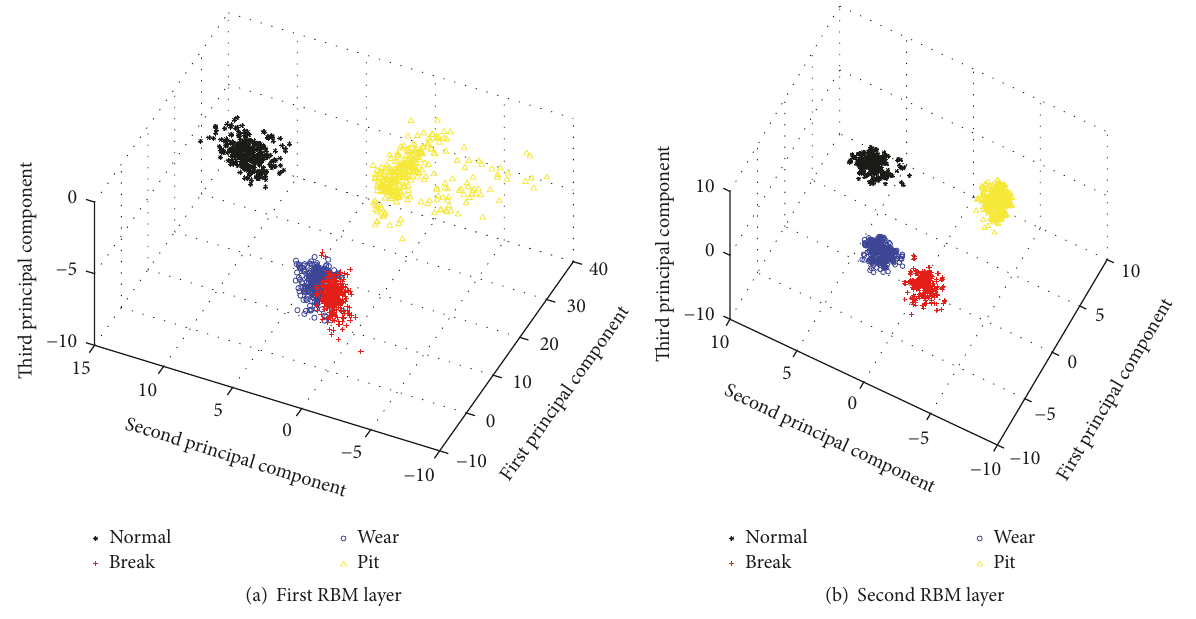
Figure 10: Features distribution of EEMD-DBN result.